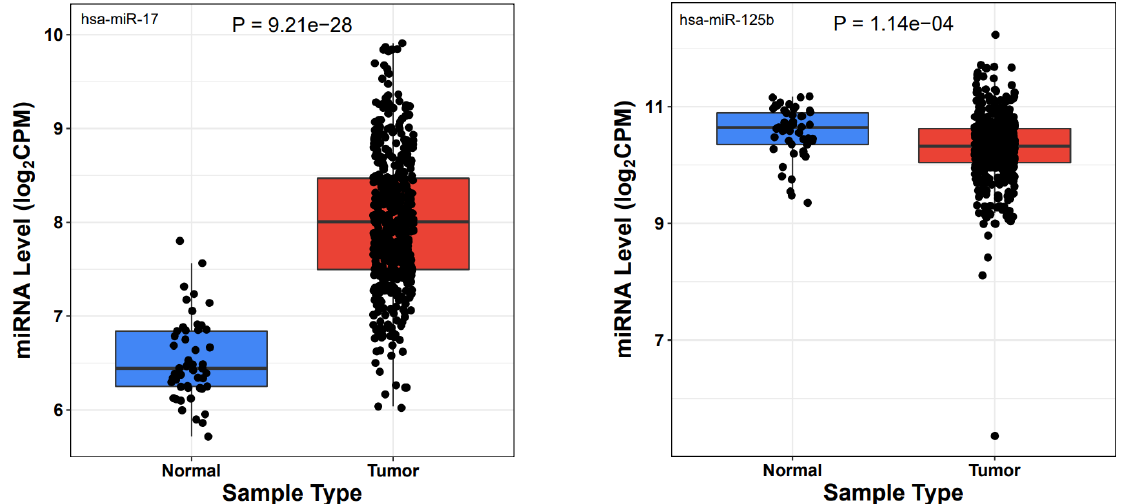
Figure 21. Box plots of the gene expression of hub genes in prostate and normal samples based on TCGA. Red and blue boxes show the gene expression of hub genes in prostate and normal samples, respectively. The red star in some boxplots means that the expression difference between the samples is significant.